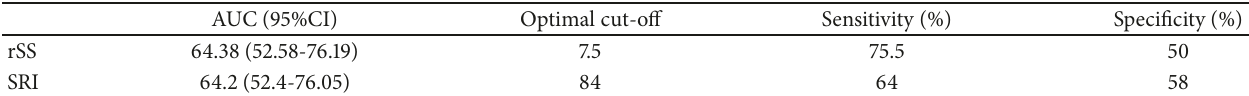
Table 5: Predictive capabilities of residual SYNTAX Score and SYNTAX Revascularization Index on one-year all-cause mortality. AUC = area under the curve, rSS: residual SYNTAX Score, and SRI: SYNTAX Revascularization